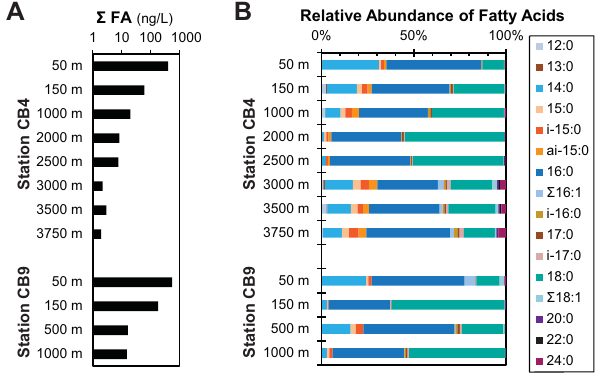
Fig. 2. (a) Summed concentration of total fatty acids. (b) Relative abundances of individual fatty acids with blue shades represent- ing even-numbered fatty acids and orange shades representing odd- numbered and branched fatty acids and purple shades representing long-chain fatty